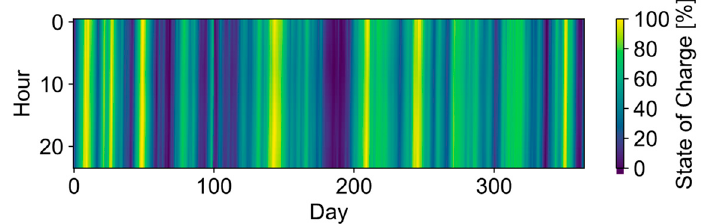
Figure A2. Case study 2—Hydrogen storage operation for 40 typical days (level 1).